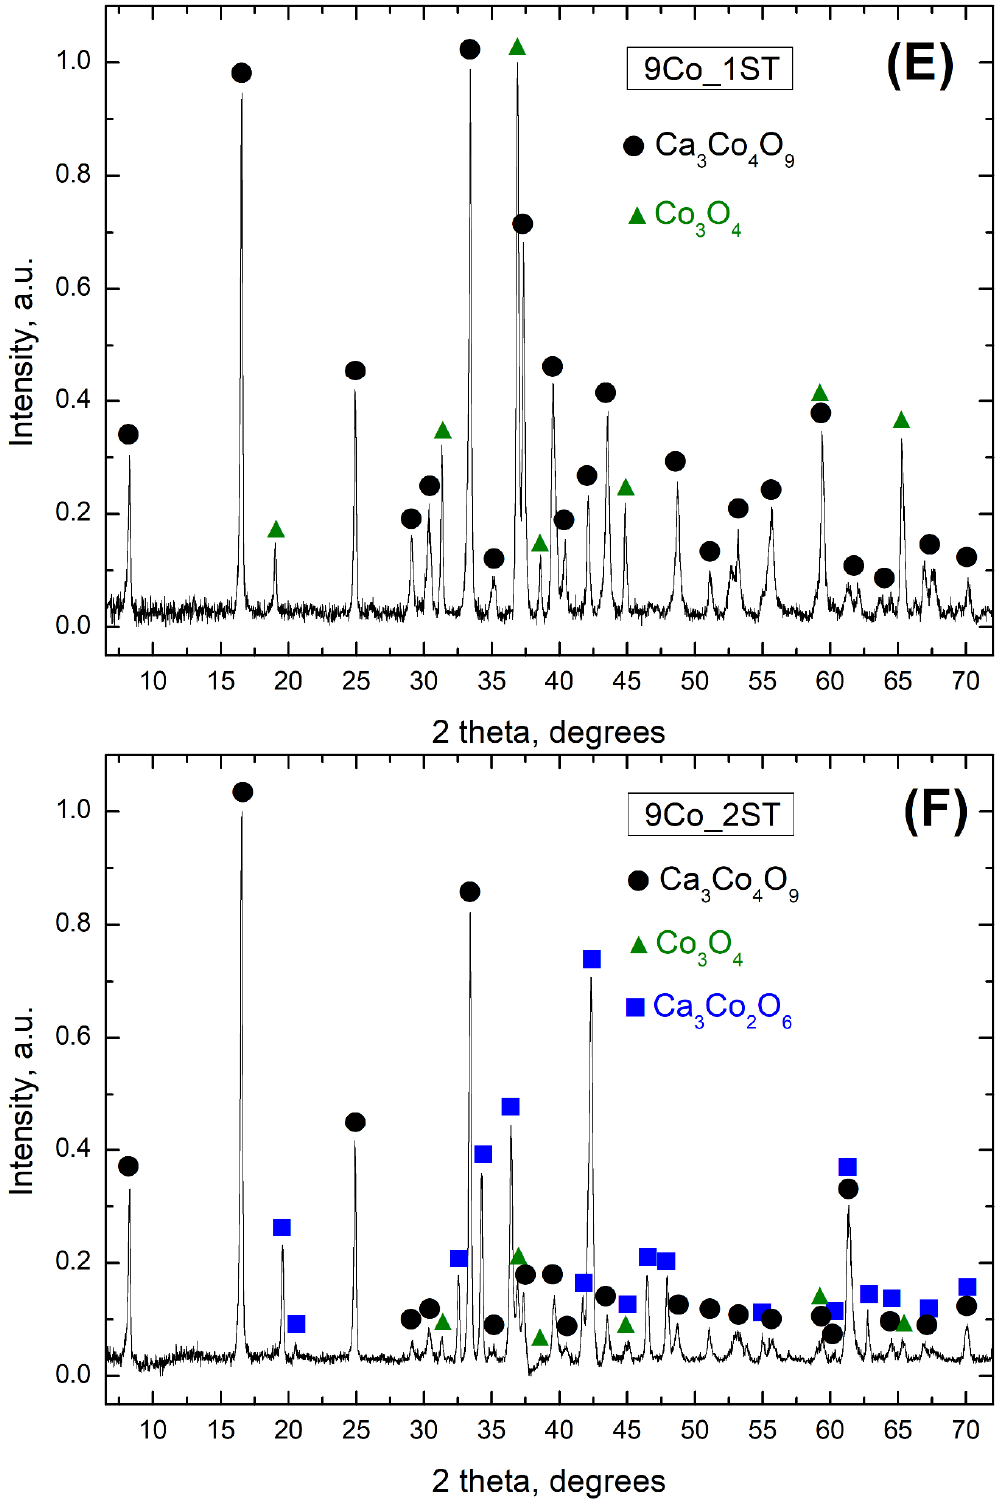
Figure 2. Normalized XRD patterns of the 1ST and 2ST sintered samples: ( A ) 0Co_1ST, ( B ) 0Co_2ST, ( C ) 3Co_1ST, ( D ) 3Co_2ST, ( E ) 9Co_1ST and ( F ) 9Co_2ST, showing the phase composition in each case. In ( A , B ), the (hkl) crystallographic planes belonging to the Ca 3 Co 4 O 9 phase are shown. Metallic cobalt readily oxidizes in the air, at temperatures above 900 K, forming a CoO and Co 3 O